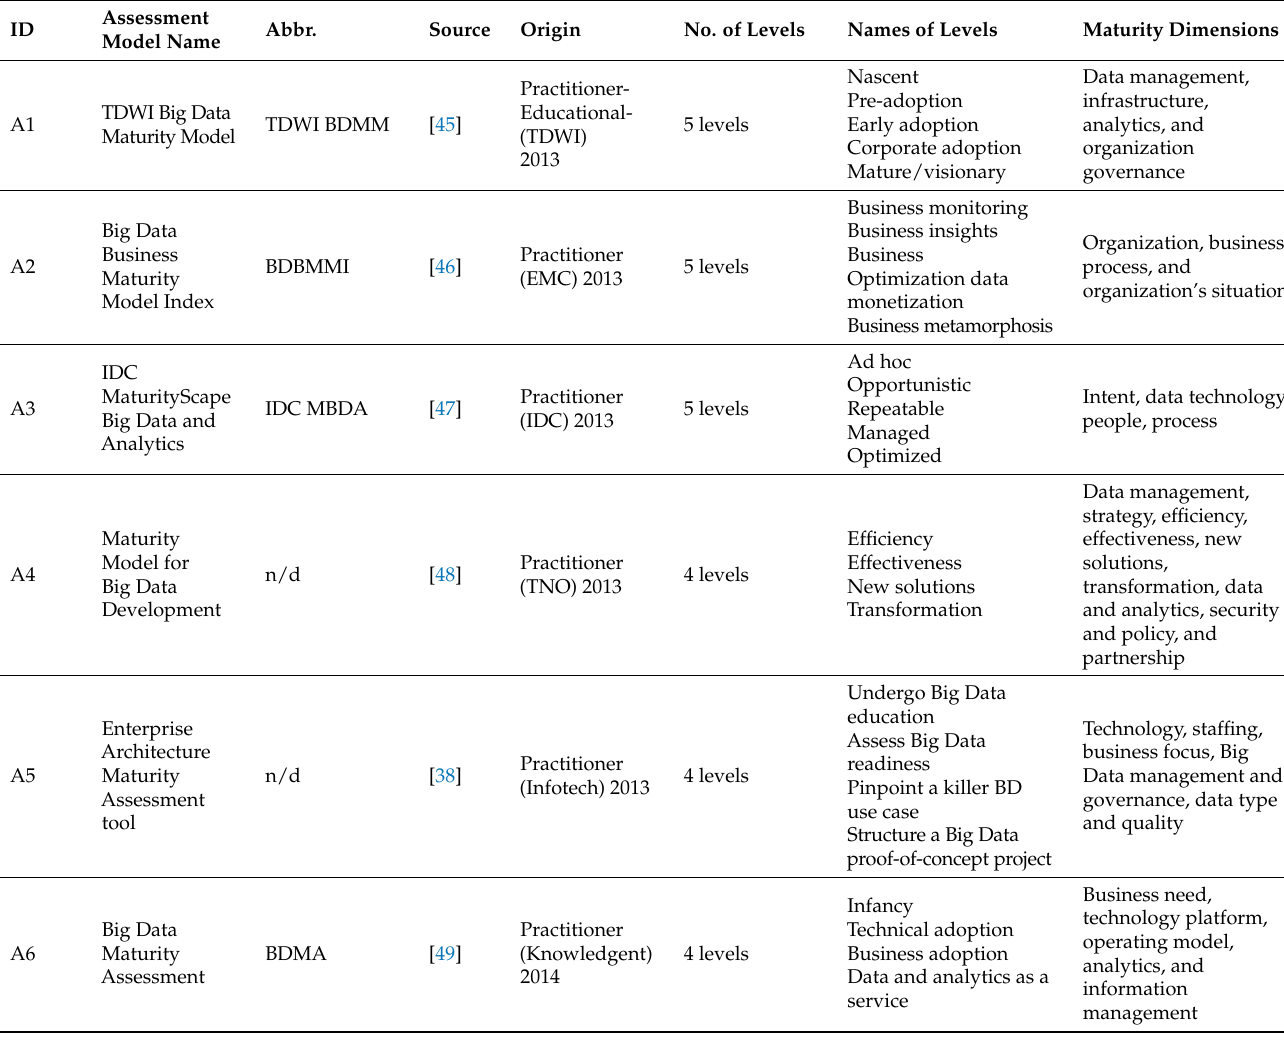
Table 6. Evaluation of the existing Big Data maturity